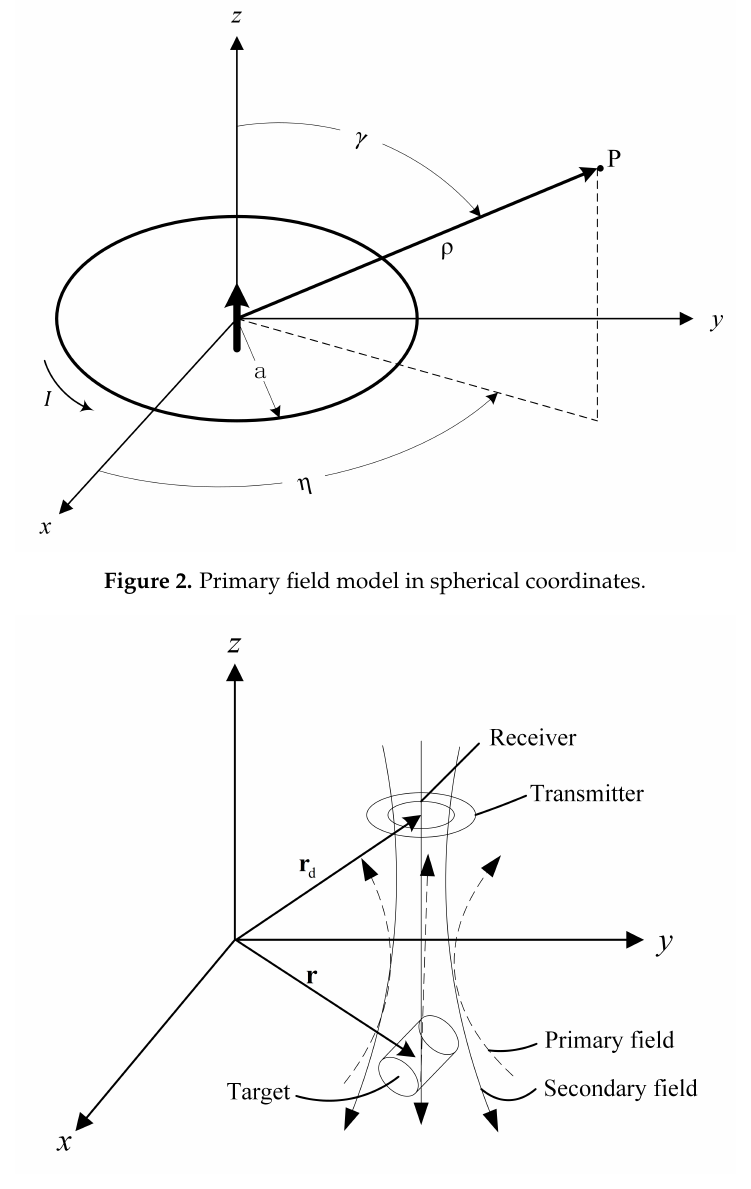
Figure 3. Diagram of electromagnetic induction (EMI)